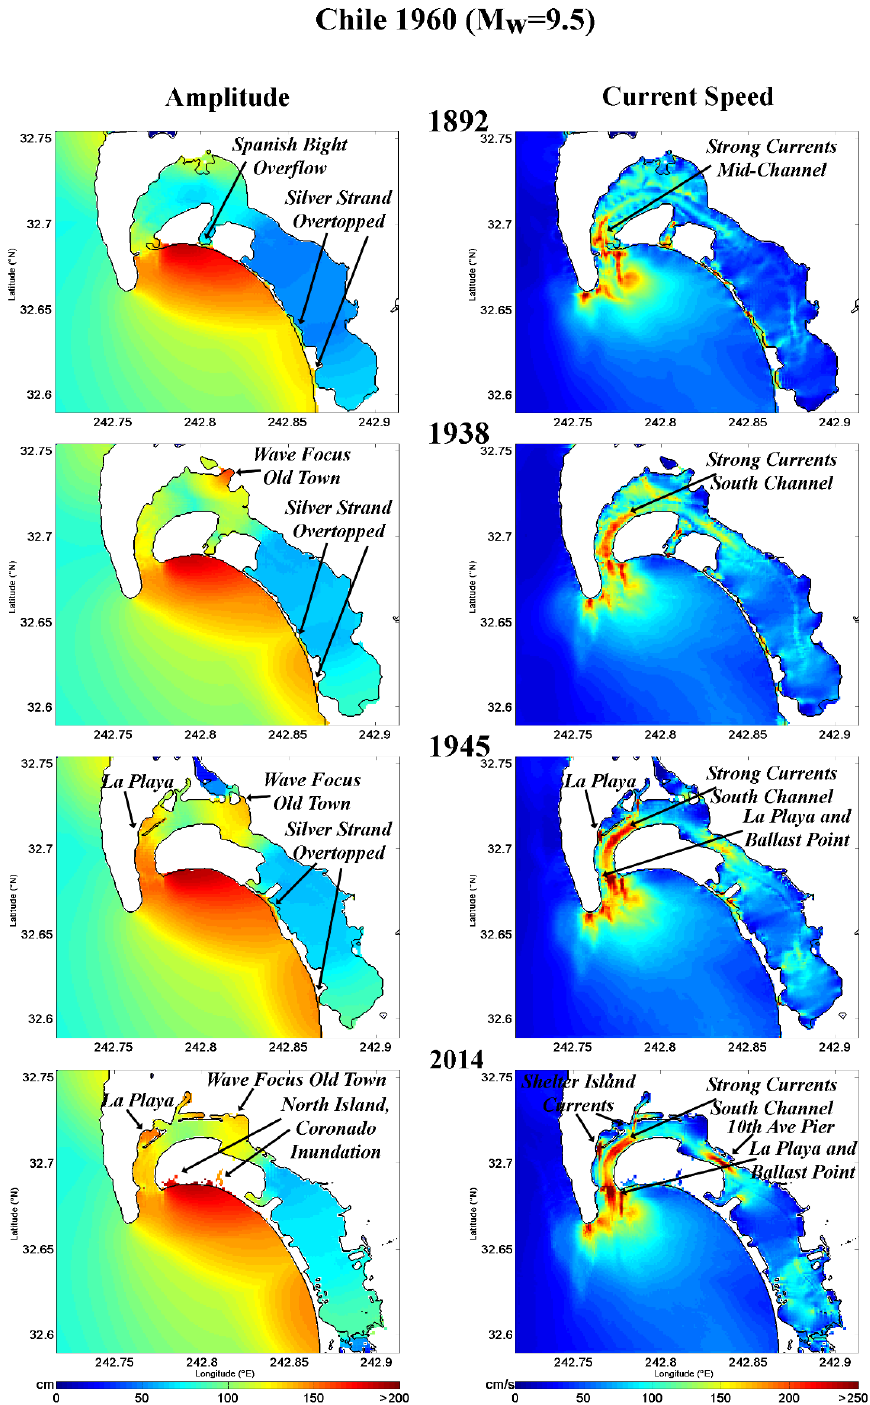
Figure 7. Maximum wave amplitude and maximum current distribution in San Diego harbor for four different configurations (1892, 1938, 1945, and 2014). A Chile 1960 type of scenario was used to investigate changes in wave dynamics as a result of anthropogenic changes. Years indicate time tagging of large changes in the harbor. Left column shows wave heights in cm; right column tsunami currents in